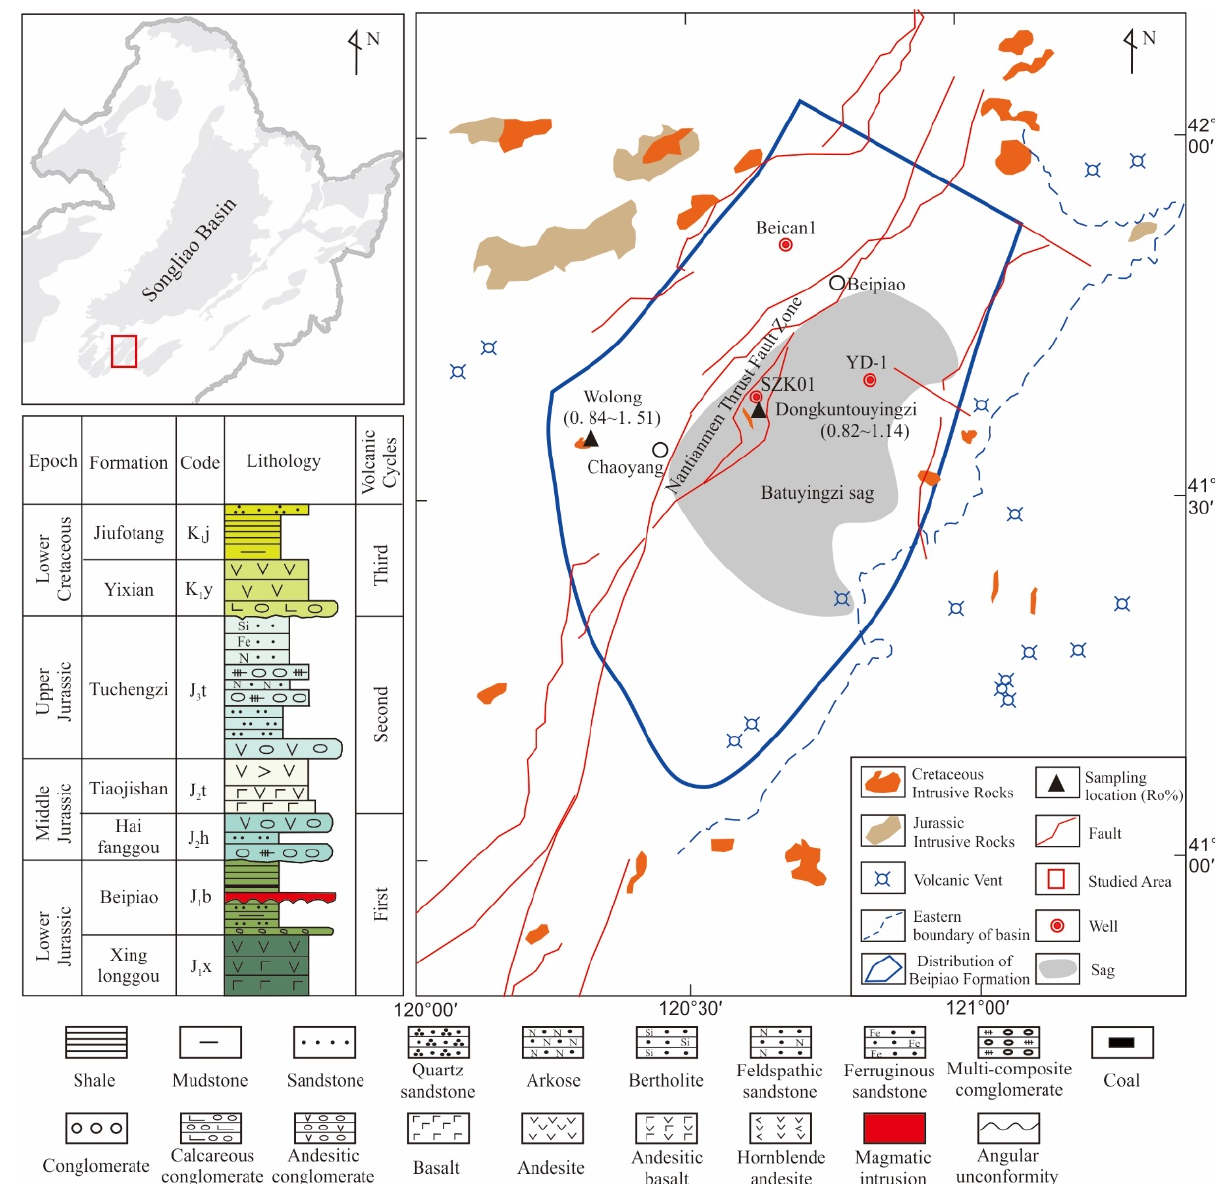
Figure 1. Location of the study area and the distribution of Jurassic and Cretaceous magmatic activities.